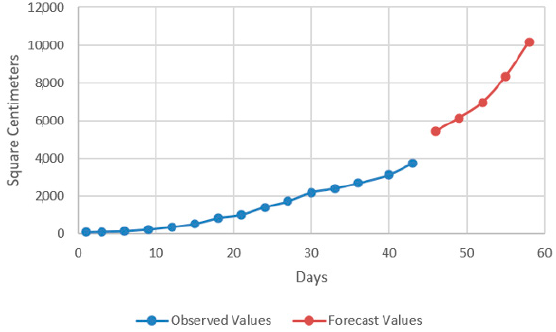
Figure 15. The evolution of basil leaves area in BH experimental variant.